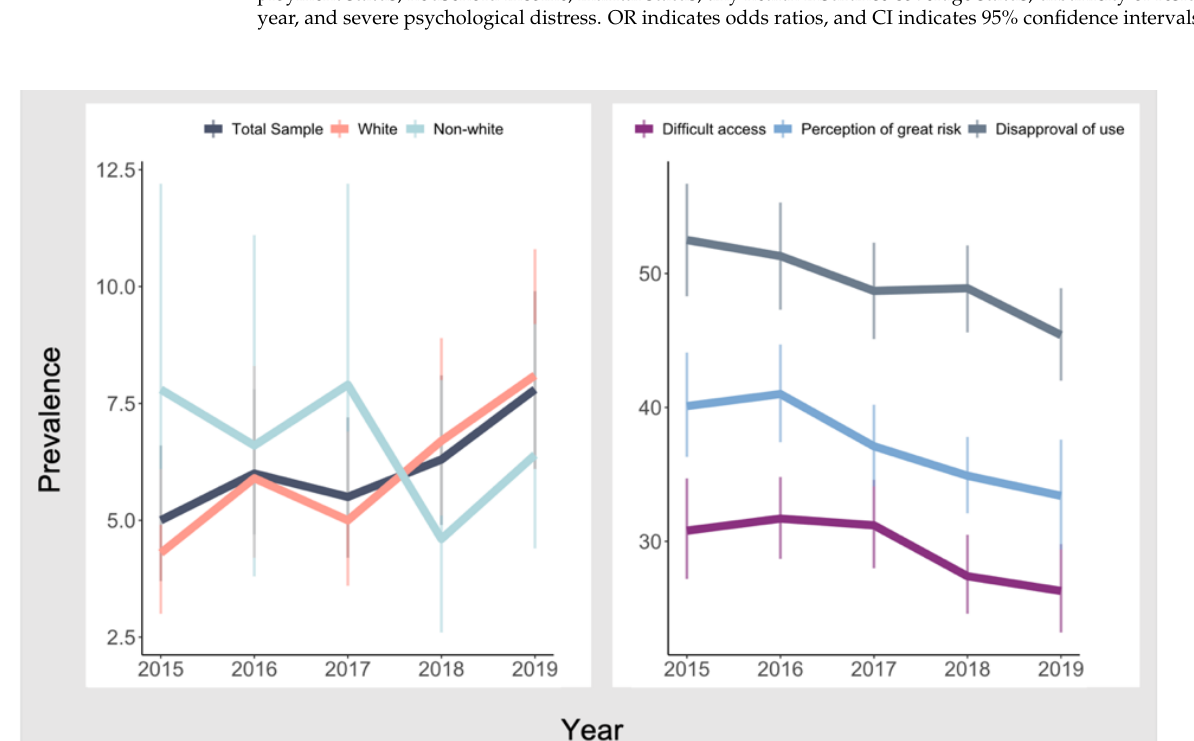
Figure 1. Trends in prevalence of past-month cannabis use and cannabis-specific factors among individuals with heart disease: pooled sample of NSDUH 2015 – 2019.